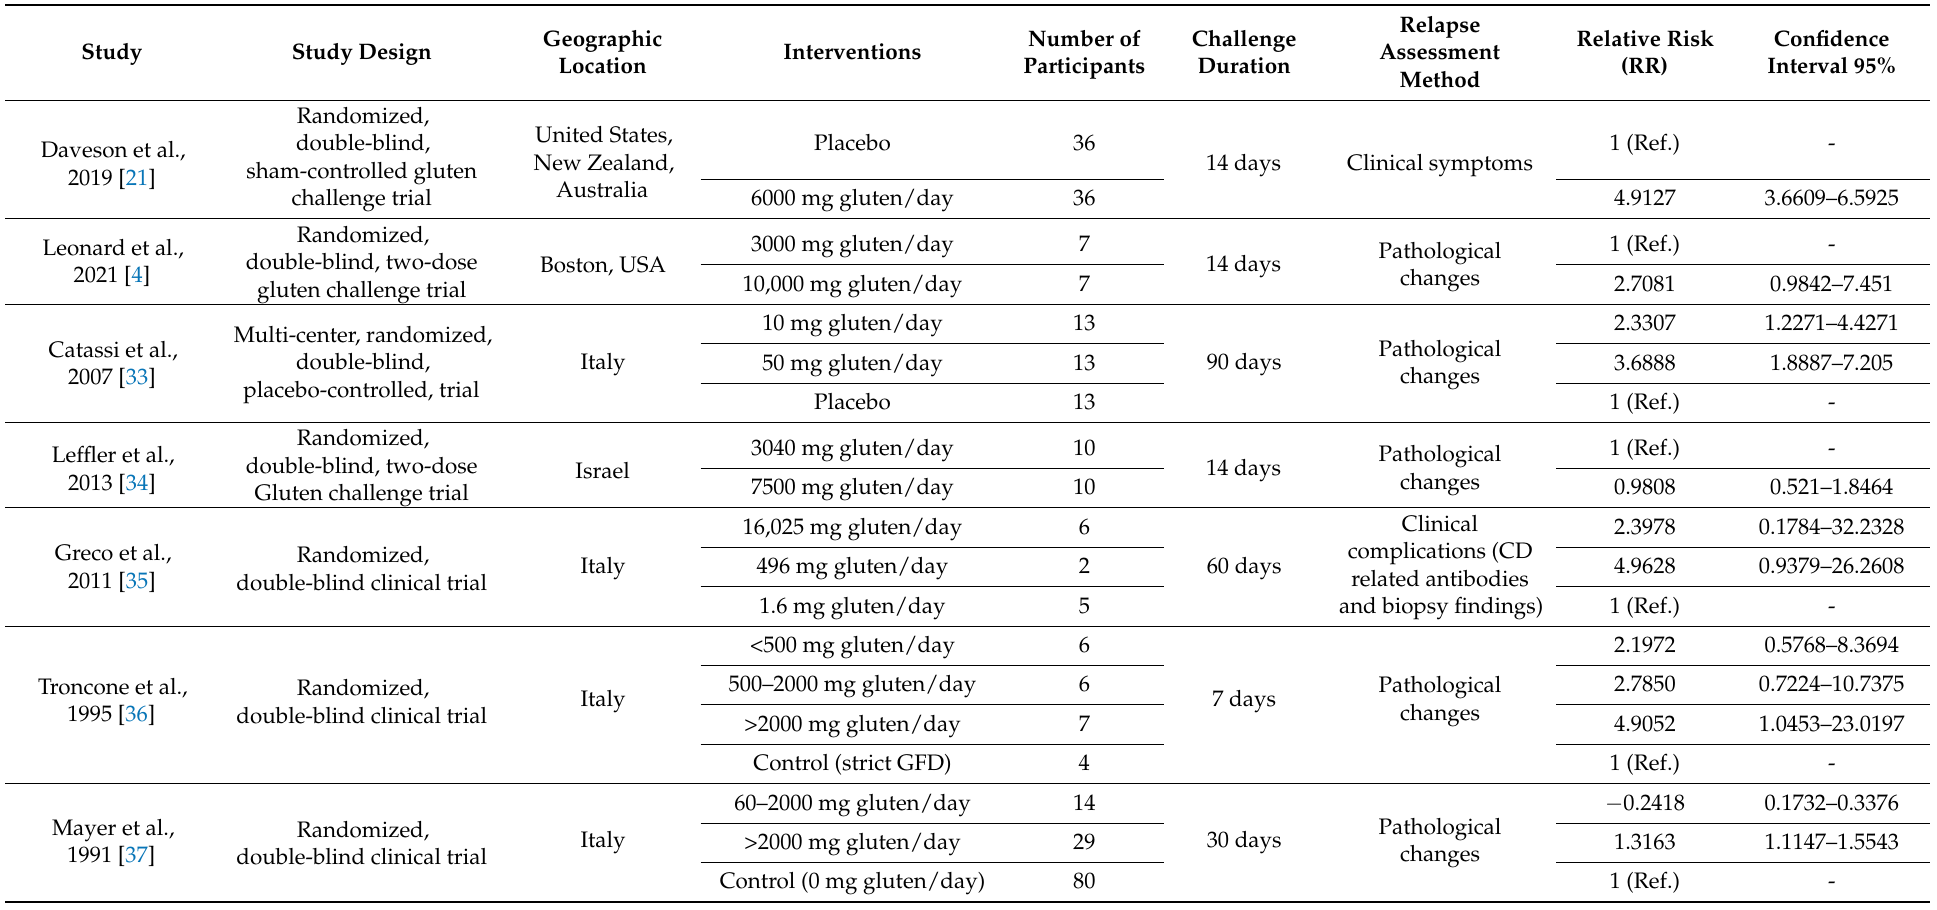
Table 1. Characteristics of the included